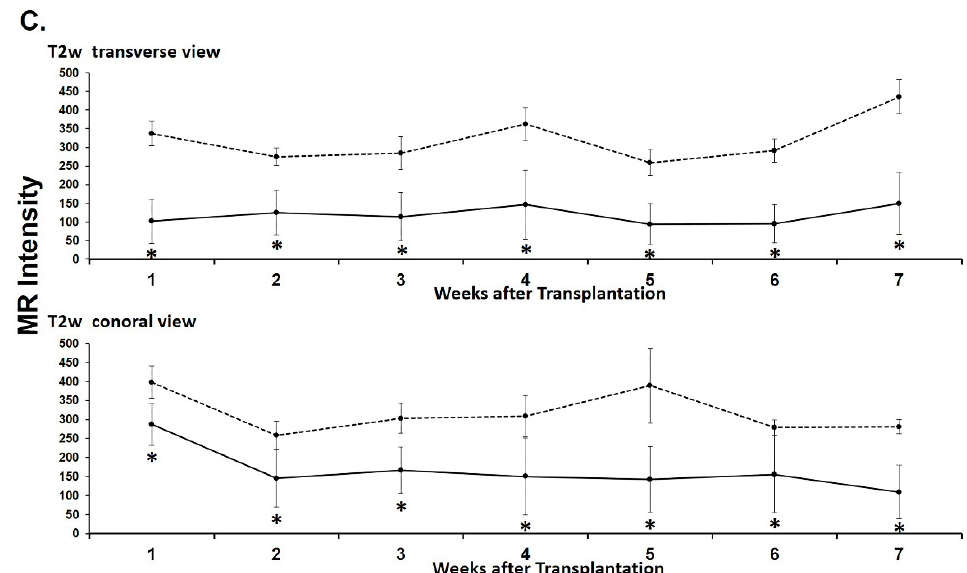
Figure 8. Seven-week in vivo MR images of the MnMEIO-Ex4 NPs-labeled islet graft. Six hundred MnMEIO-Ex4 NPs- labeled islets were transplanted under the left kidney capsule of a C57BL/6 mouse. The recipient was scanned by a 7.0 T MRI system with transverse ( A ) and coronal ( B ) sections for 7 weeks. The graft on MR images was indicated by arrows. ( C ) Time course of the MR signal intensity of the graft on left kidney (solid line) and the mirror area on the right kidney (dash line) in the mouse transplanted with 600 MnMEIO-Ex4 NPs-labeled islets. * p = 0.000.